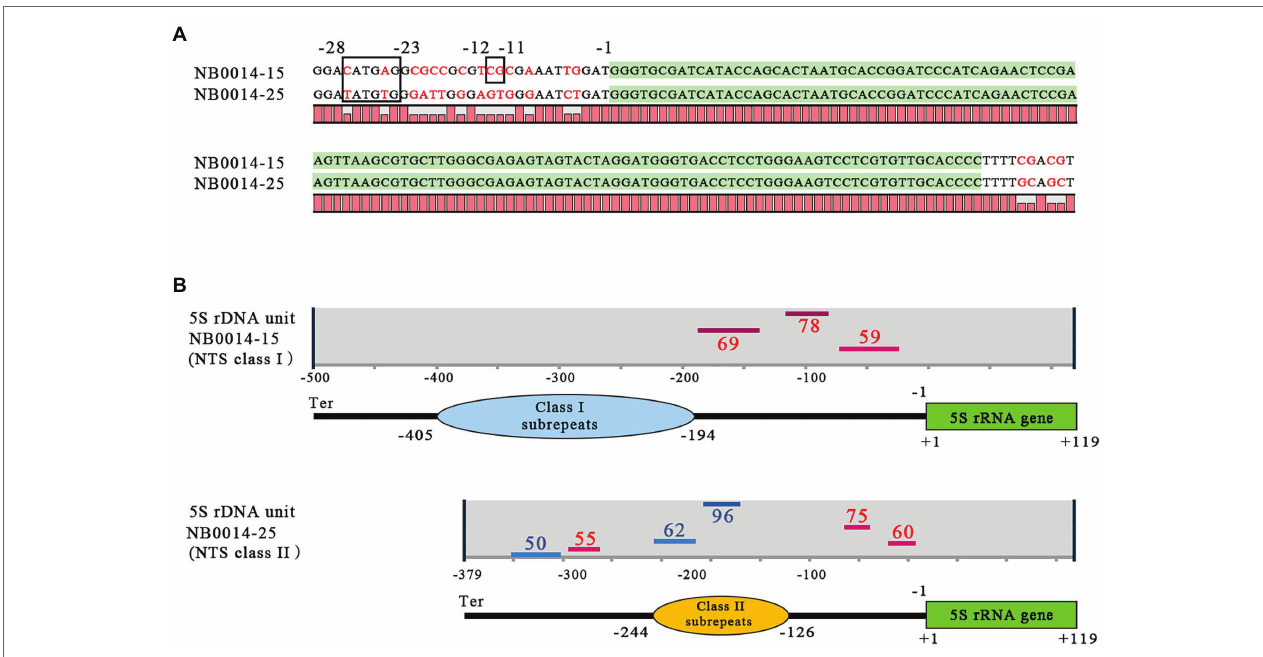
FIGURE 4 | Features of class I and class II NTS sequences with the potential to modulate 5S rDNA transcription. (A) Regulatory DNA elements upstream and downstream of the 5S rDNA gene. The coding sequence for the 5S rRNA is highlighted in green; nucleotide positions from − 28 to − 23 mark the TATA-like motif; nucleotide positions − 12 to − 11 mark the GC dinucleotide; position − 1 marks the first nucleotide upstream of the 5S rDNA transcription start. (B) Patterns of G-quadruplex structures predicted for class I and class II NTS sequences. Positions of G-quadruplex structures are indicated by horizontal lines (red for forward DNA strand, blue for reverse strand); numbers next to bars indicate the relative strength of each G-quadruplex structure, and the negative ( − ) numbers indicate their positions relative to the transcription start of the 5S rDNA gene; Ter marks the position of the terminator with sequence TTTT. NTS, nontranscribed